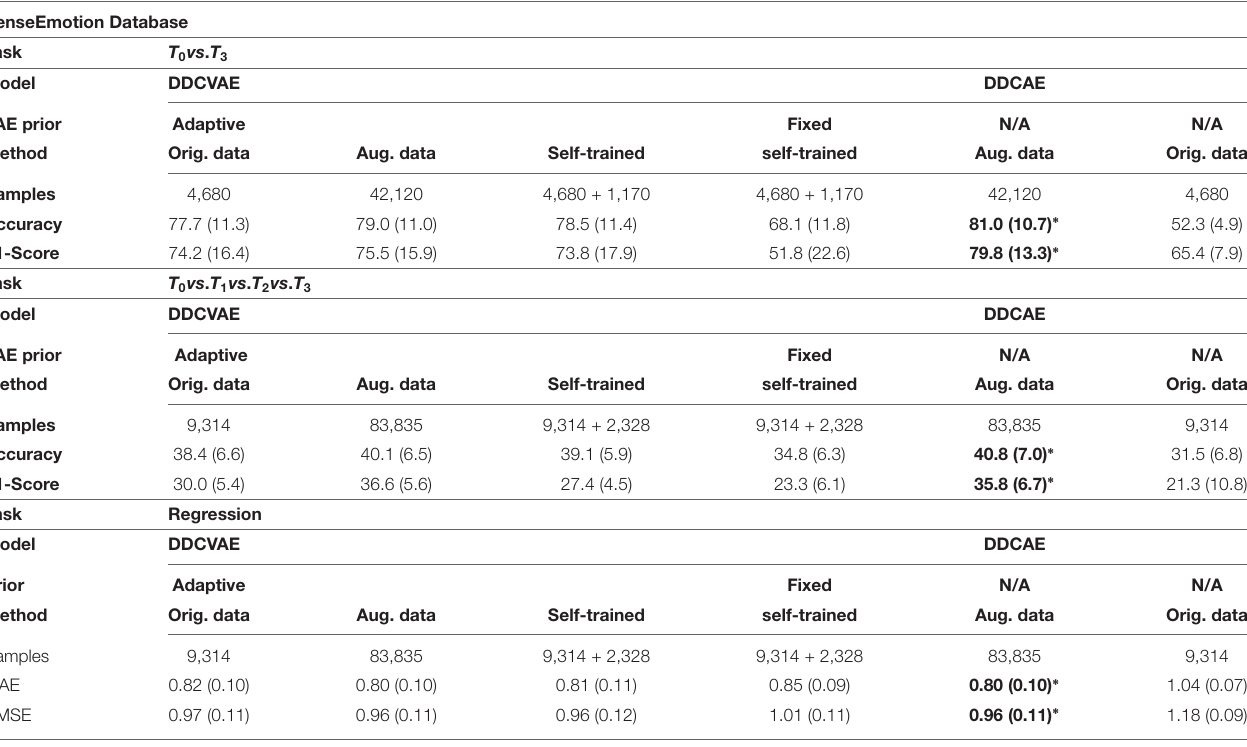
TABLE 6 | Results for the SenseEmotion dataset in the binary, four classes, and regression setting in a Leave One Subject Out (LOSO) cross-validation evaluation setting: average performance in % (standard deviation in % ). SenseEmotion Database